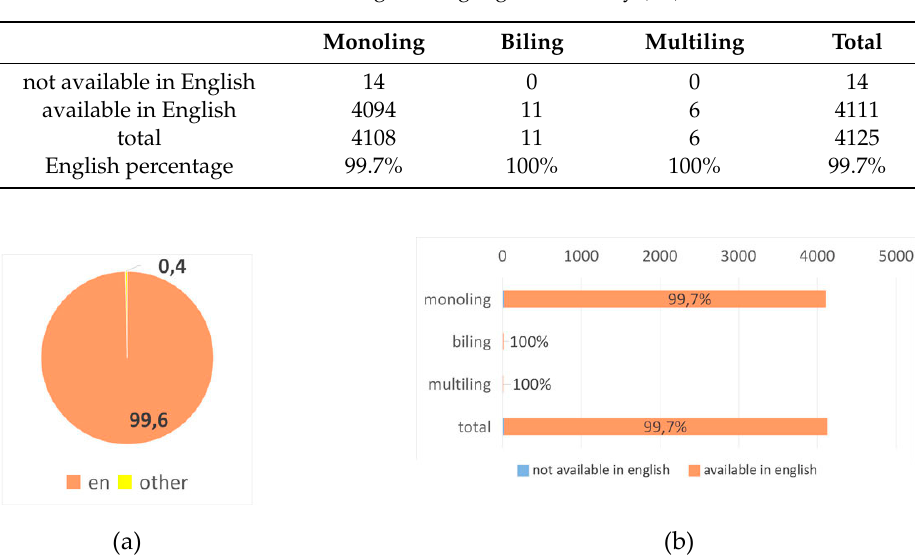
language availability bar chart.